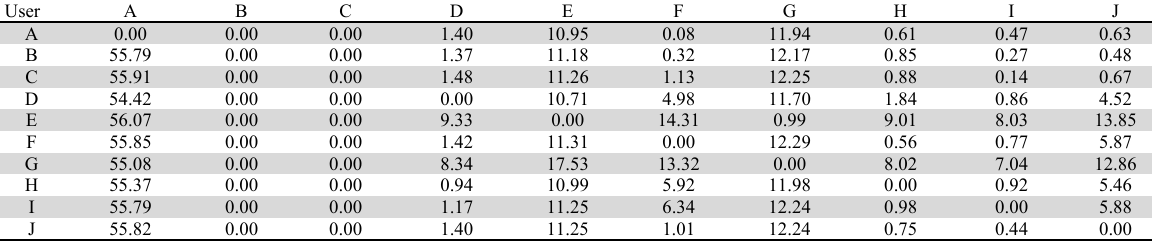
Time between successive tweets about covid19 vaccination between 10 followers-followees (in hours) User A B C